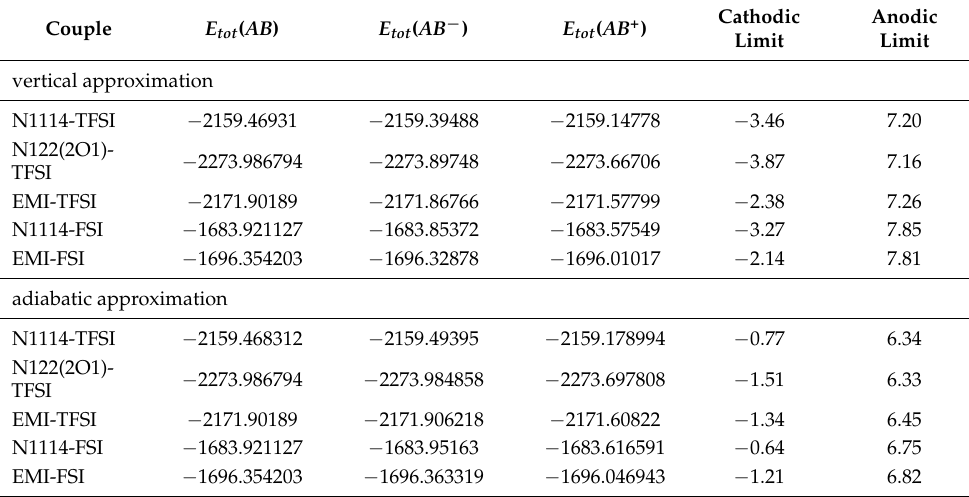
Figure 2. Comparison of the anodic limit calculated for trans-TFSI and trans-FSI with various theory levels, in vacuum or in a polarizable medium, considering a vertical or an adiabatic transition between differently charged states. The horizontal colored regions display the interval of values of the experimental anodic stability of the TFSI- and FSI-based ionic liquids investigated computationally in this paper. Table 8. Electronic energy (in atomic units) of the neutral ionic couples and of the ionic couple with the addition or removal of an electron, without or with the possible relaxation of the geometry and derived cathodic and anodic limits (in V). All calculations were performed at the B3LYP/6-31G** level of theory in gas